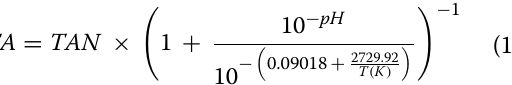
OL, organic loading; VS, volatile solid; TS, total solid